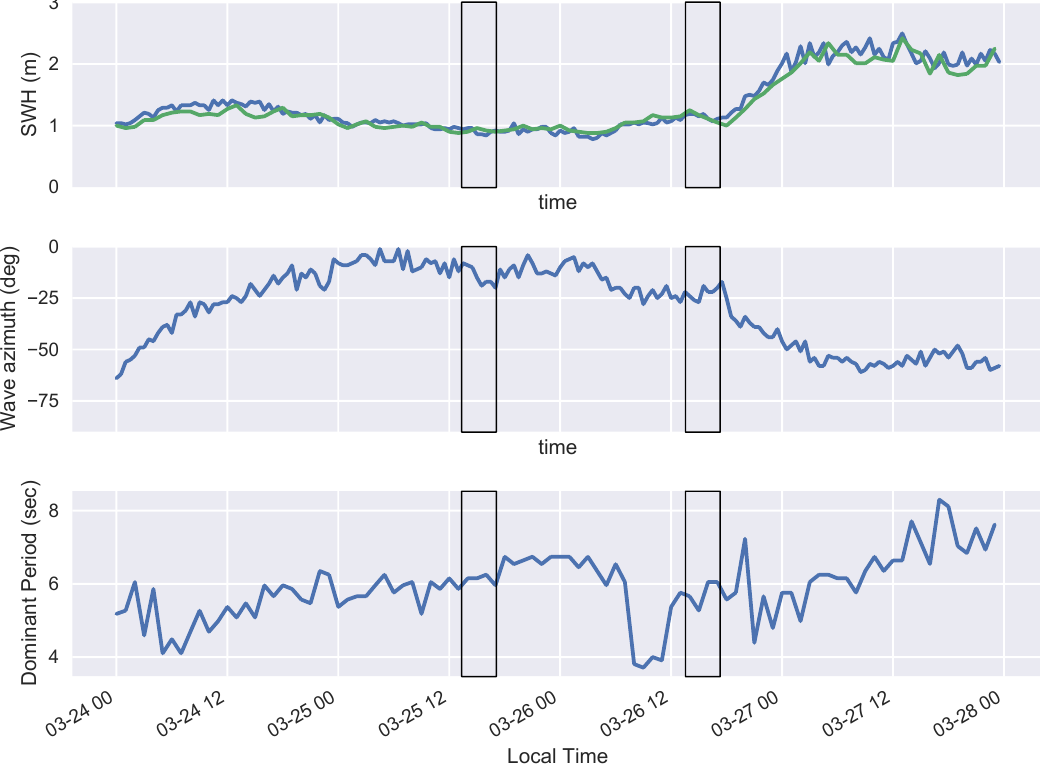
Figure 3. Significant wave height ( top ) and dominant wave direction ( bottom ) collected by the Fugro METIS and NDBC buoy. Data collection times are outlined black